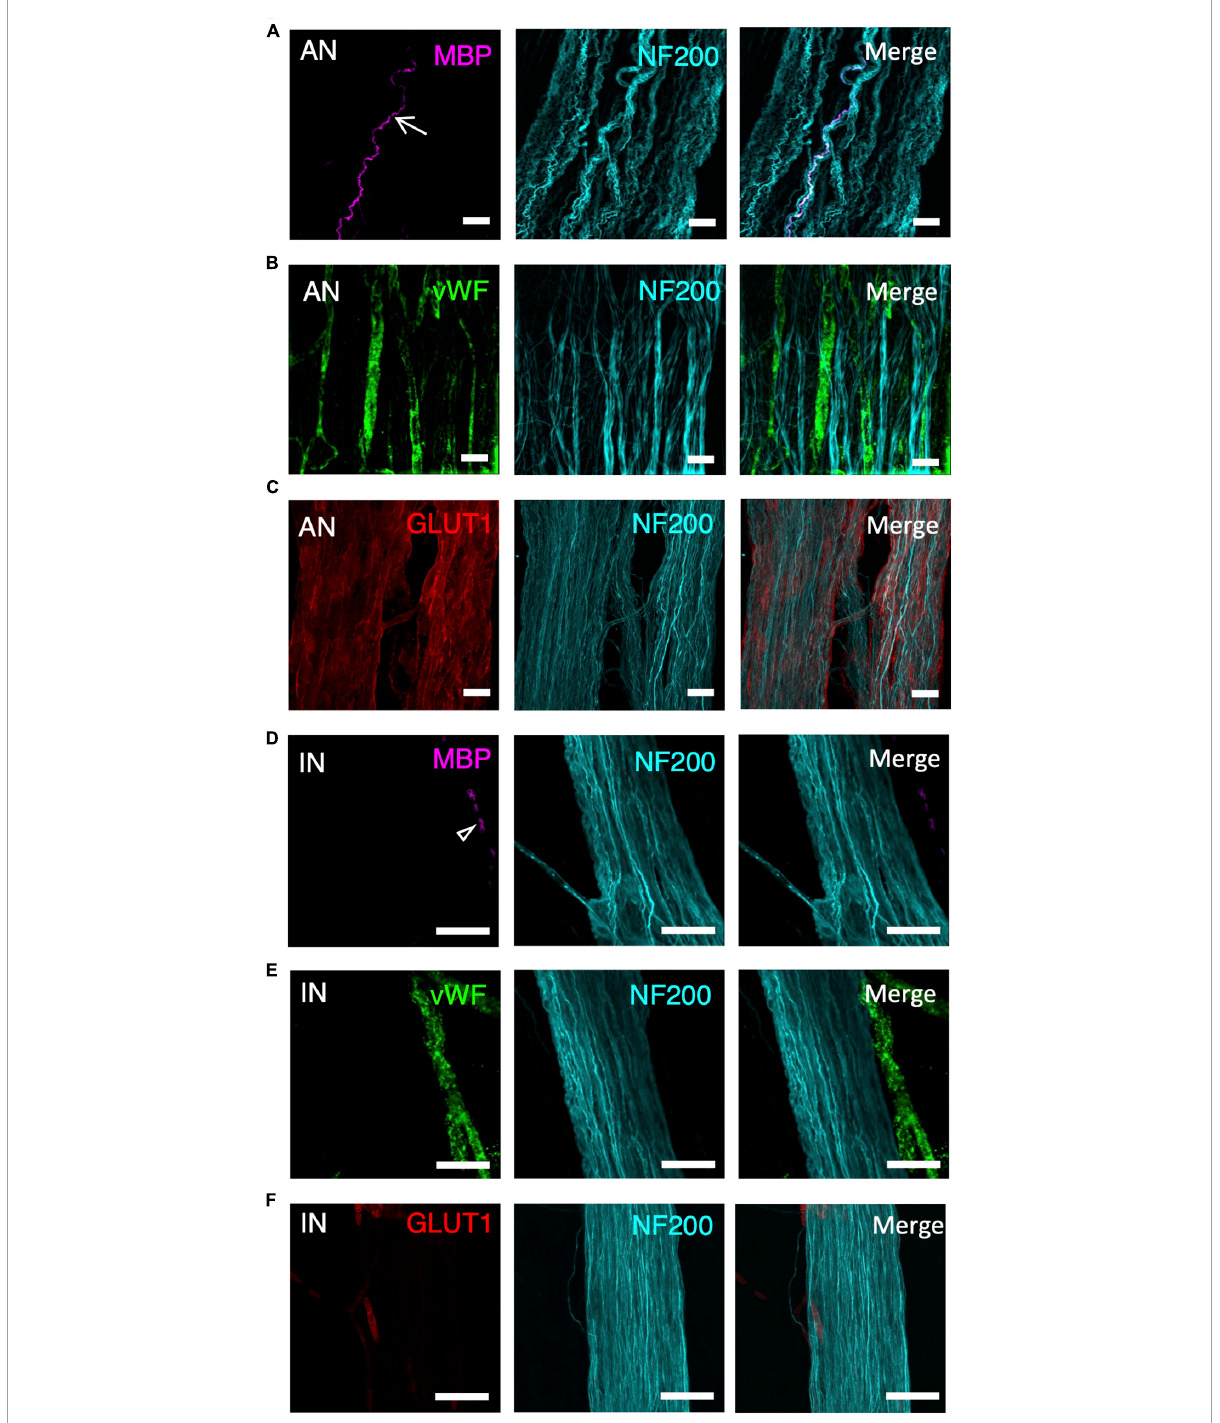
FIGURE2 A panel of markers, applied with neurofilament-H (NF200), was used to differentiate ascending nerves (AN) from internodal strands (IN) shown at high magnification (40 × ). This panel included myelin basic protein (MBP- A-AN, D-IN), von Willebrand factor (vWF- B-AN, E-IN), glucose transporter 1 (GLUT1- C-AN, F-IN), and neurofilament-H (NF200). (A,D) Arrow indicates a myelinated axon—these were not present in all ascending nerves (A) . No myelinated axons are labelled in the internodal strand (D) although there is some fluorescence from dense collections of red blood cells (open arrowhead). (B,E) vWF fills several blood vessels running between multiple strands of an ascending nerve (B) . In contrast, vWF labelling lies outside the internodal strand (E) . (C,F) GLUT1 labels a multi-stranded ascending nerve that fills most of the image (C) , whereas internodal strands rarely showed GLUT1 immunoreactivity; when present it was confined to small, isolated patches (F) . All scale bars = 50 µ